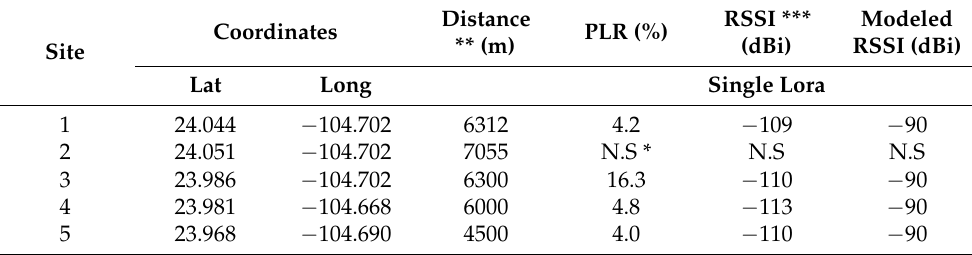
Figure 7. Modeling of RSSI (received signal strength indication) by SPLAT, according to the configu- ration of the proposed localization of the node and gateway for IoT-WQSM. (1,2,3,4,5) Locations of interest tested onsite with the WQSM system. Table 2. Comparison of RSSI modeled with splat software and measurements obtained with two different LoRa configurations at the sites of